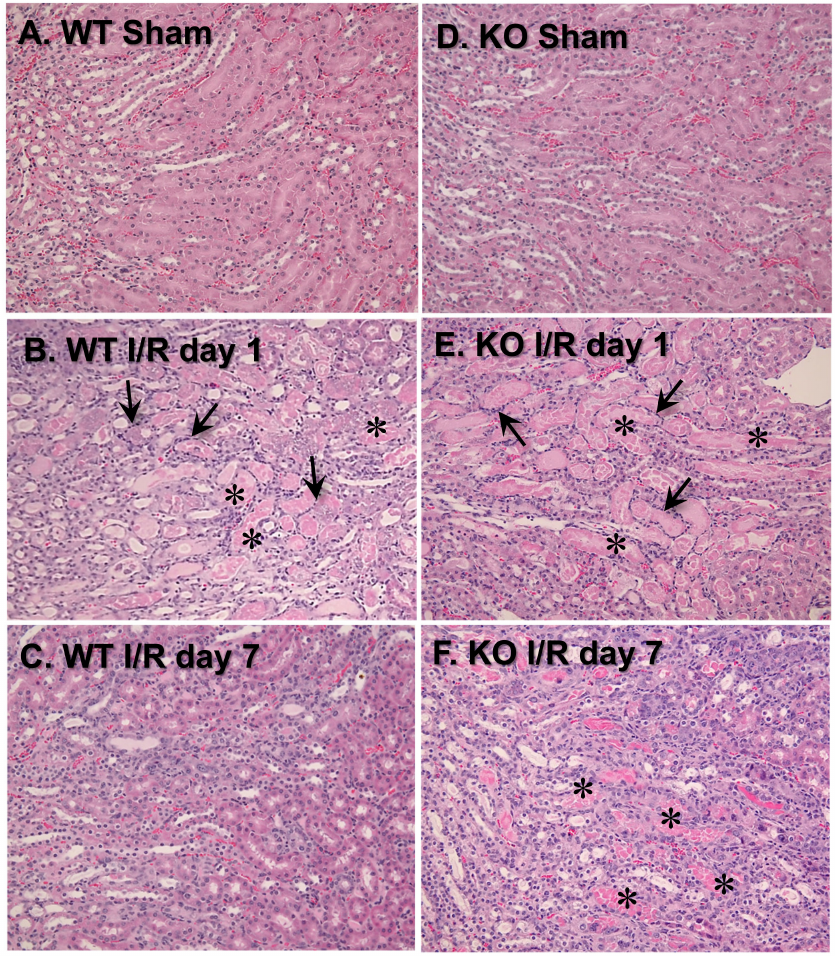
Figure 3. Deletion of VDAC1 exacerbates ischemia-induced damage to morphology of renal proximal tubules and impairs renal tissue regeneration after acute injury. On days 1 and 7 after ischemia, kidneys were harvested, immersed, fixed in 4% neutral-bu ff ered formaldehyde, and embedded in para ffi n. Thin (4–8 µ m) sections were cut and stained with hematoxylin-eosin. Renal histology of